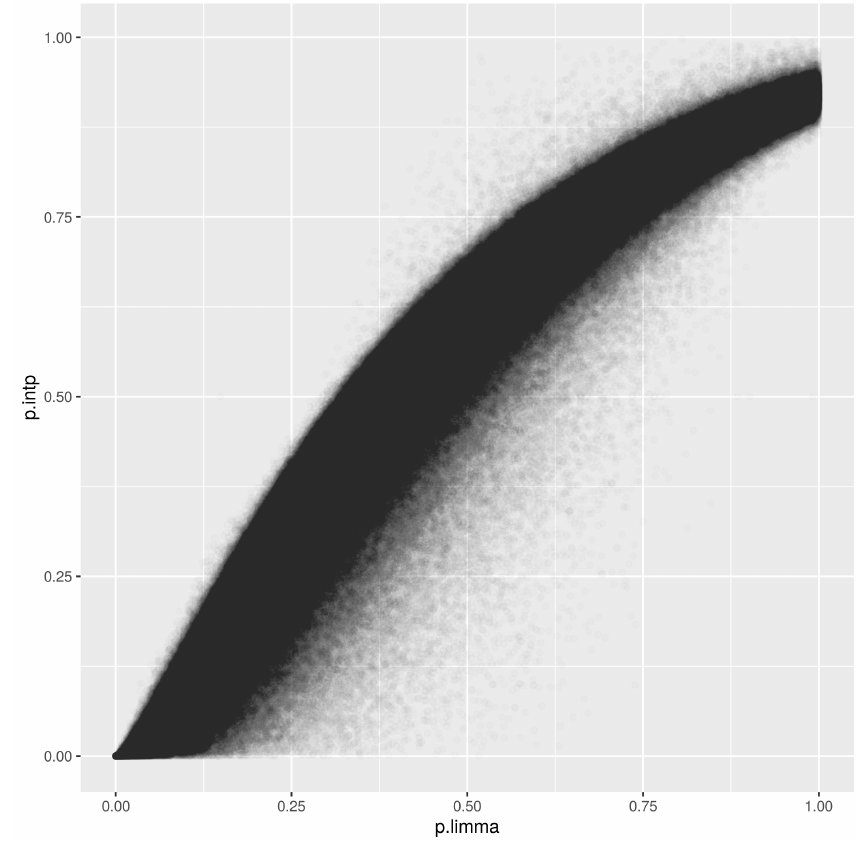
Figure 4. Comparison between our score and p -values obtained using the method limma for the infinium methylationEPIC